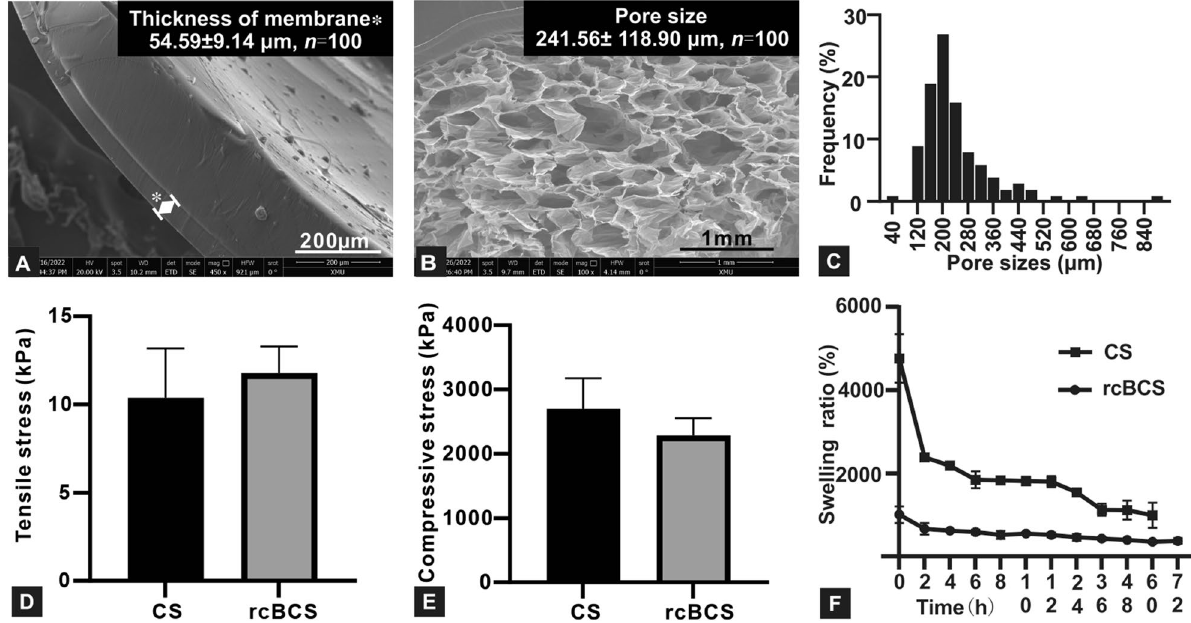
Figure 2. Physico-chemical characterization of radiation crosslinked bilayer collagen scaffold (rcBCS). ( A ) Scanning electron microscopy observation of the microstructures of silicone membrane (*) with liquid silicone. ( B ) Scanning electron microscopy observation of cross-section structure of rcBCS. ( C ) The distribution of pore sizes of rcBCS. ( D ) Tensile stress at maximum load of rcBCS relative to collagen scaffold (CS). ( E ) Compressive stress at maximum load of rcBCS relative to CS. Data are expressed as mean ± SD. ( F ) Swelling ratio of the rcBCS and CS shows high swelling